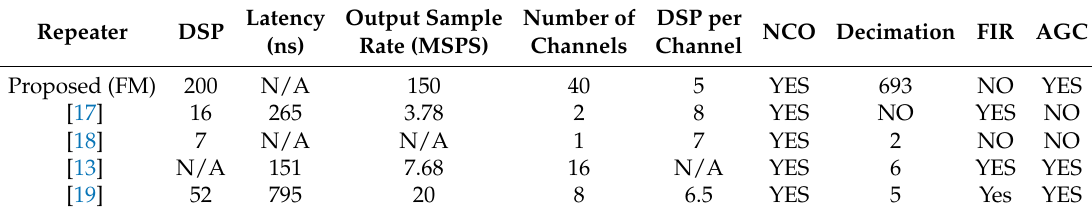
Table 9. Comparison between proposed and other FPGA-based repeaters for the FM signal.